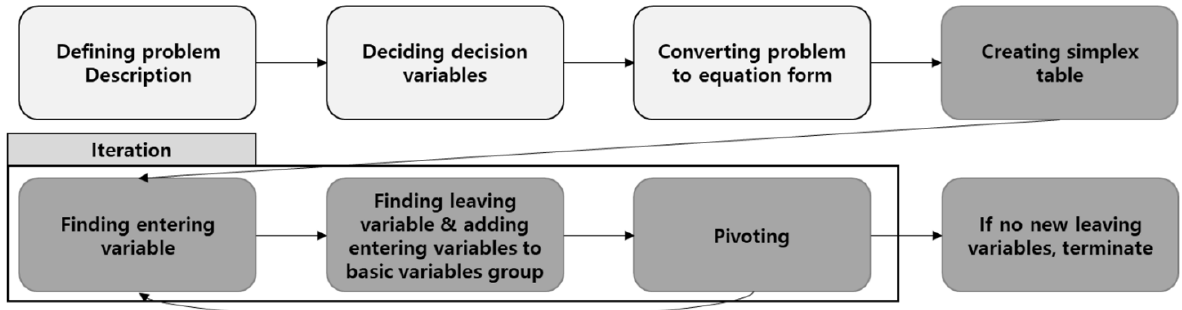
Figure 2. Solution process of the simplex method.